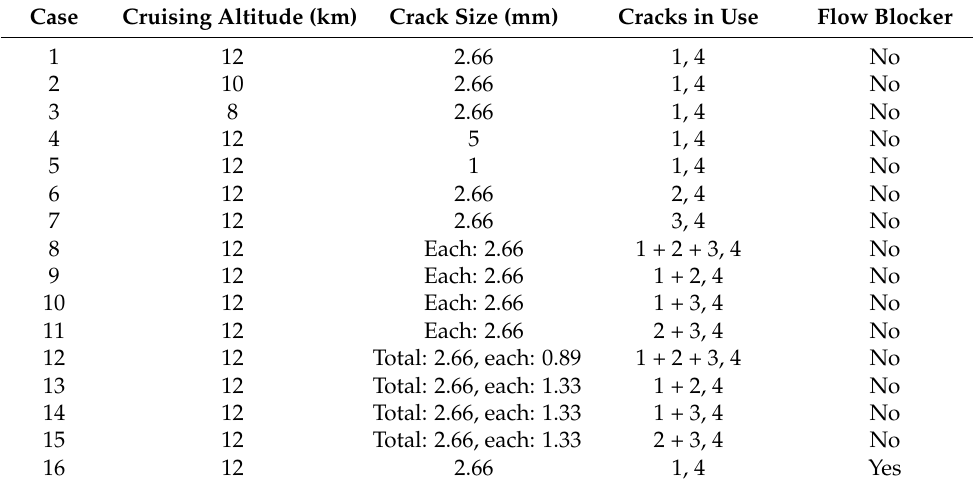
Table 1. CFD modeling case design